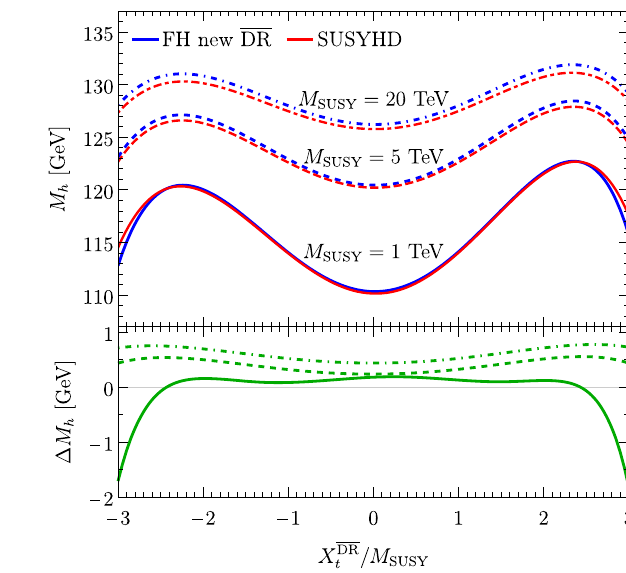
Fig. 3 Comparison of the M h predictions of FeynHiggsnew DR with SUSYHD . Left: M h as function of M SUSY for X DR t / M SUSY = 0 (solid) and X DR t / M SUSY = 2 (dashed). Right: M h as function of X DR t / M DR for M SUSY = 1 TeV (solid), M SUSY = 5 TeV (dashed) SUSY